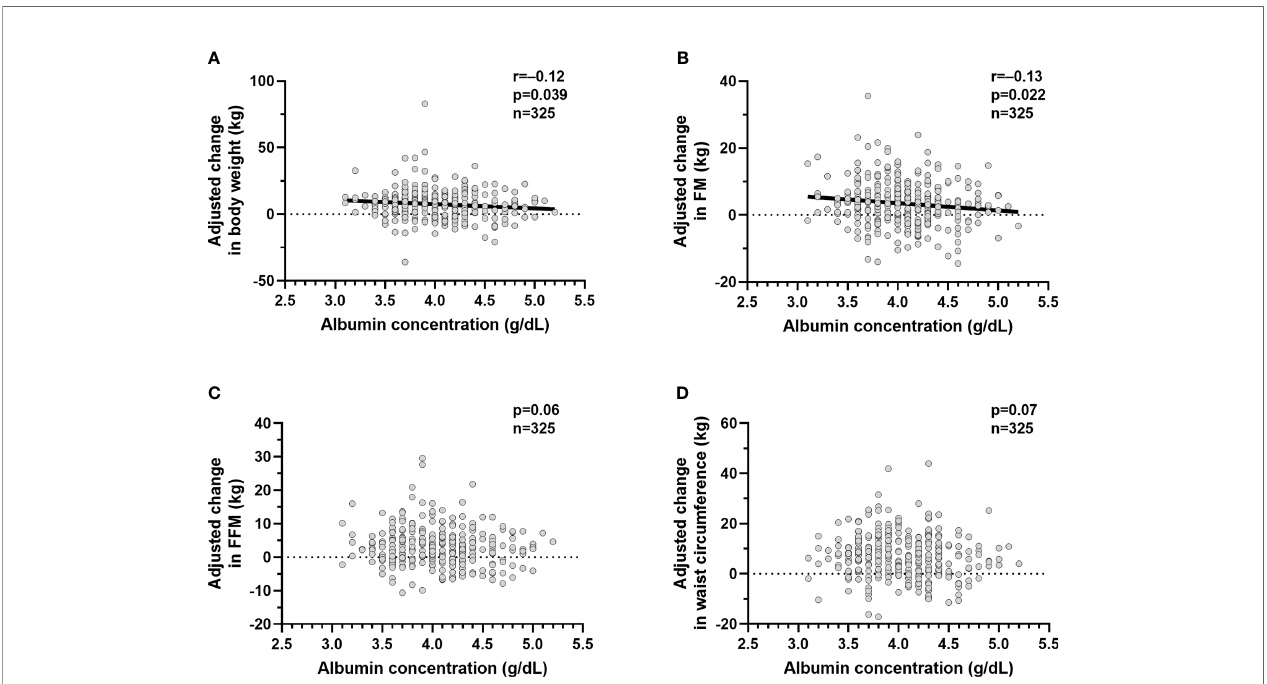
FIGURE 3 | Relationships between plasma albumin concentrations and change in body weight and body composition. Relationships between plasma albumin concentration (g/dl) and adjusted mean change in body weight (A) , adjusted mean change in fat mass (B) , adjusted mean change in fat free mass (C) and adjusted mean change in waist circumference (D) . The adjusted mean change in body weight, fat mass,fat free mass and waist circumference values were calculated via linear regression analysis including age, sex, follow up time in years after adding the average of the mean change in body weight, mean change in fat mass, mean change in fat free mass and mean change in and waist circumference to the residual values obtained from the regression model. In each panel, the Pearson ’ s correlation coef fi cient (r) is reported along with its signi fi cance (p). The dots represent values for the volunteers who completed the inpatient part of study 1 (n=325) and who returned for the follow up visit (n=325). The participants recruited were only Native